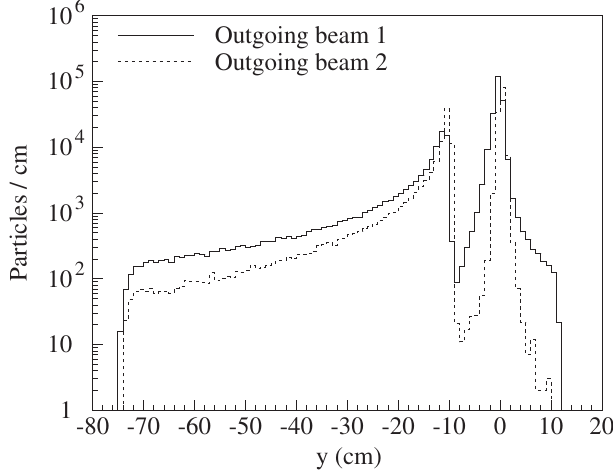
FIG. 24. Vertical profiles for the charged beams and the beam- strahlung photons at the end of each post-collision line, when the incoming beam 1 has twice the transverse dimensions of the incoming beam 2 at the interaction point. The distributions shown here correspond to 10 5 e þ e (cid:1) collisions, and not one bunch crossing.